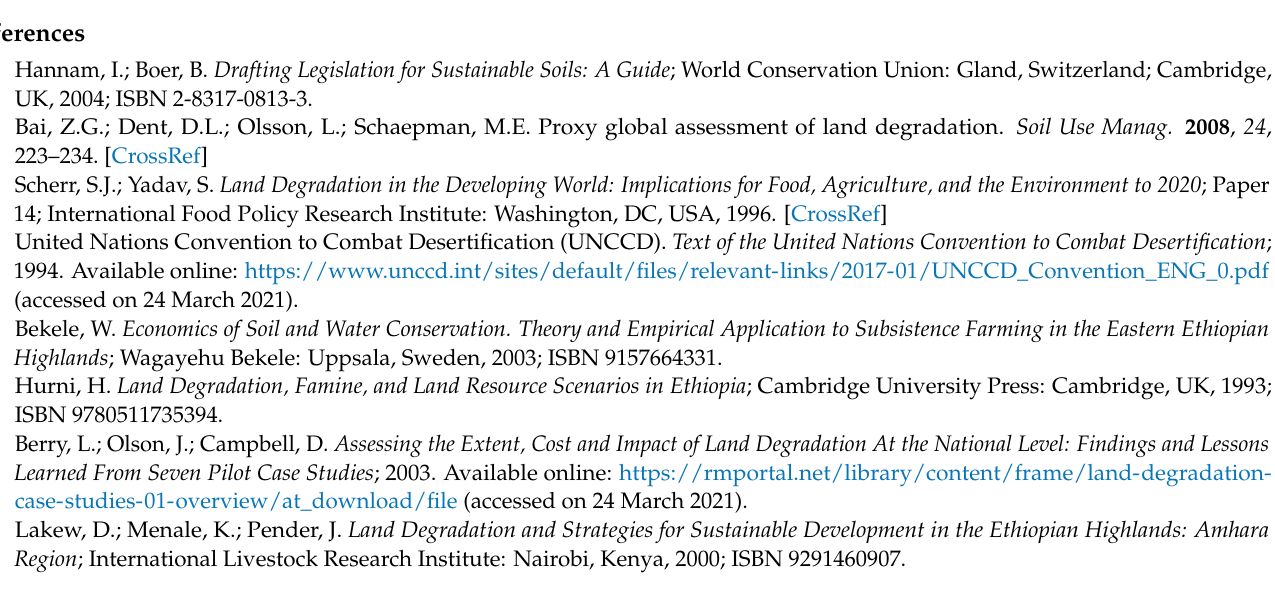
Figure A6. Regional OLS regression models for check dams with ( a ) the median of all trend differences and ( b ) the proportion of significant positive trends during 2011–2018 within the zones as dependent variable. The red line shows the linear slope when including zones up to 250 m distance, the blue line when including zones up to 500 m. ** p < 0.01, *** p <